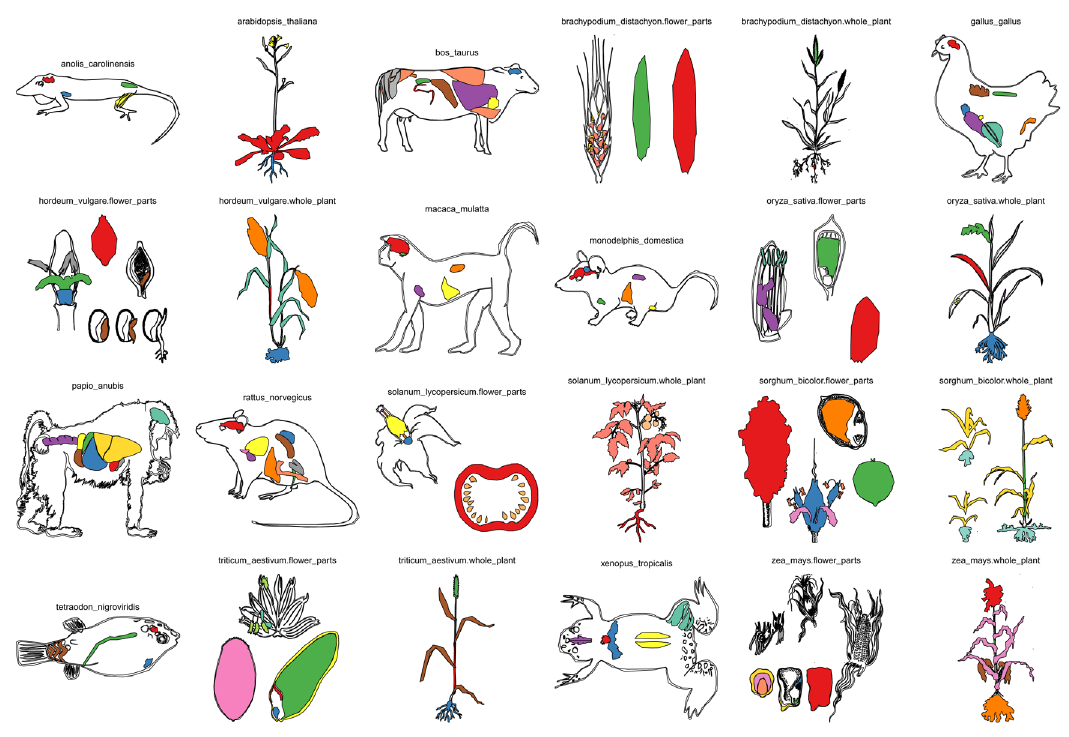
Figure 8. All 24 other organisms present in gganatogram with all their tissues plotted.